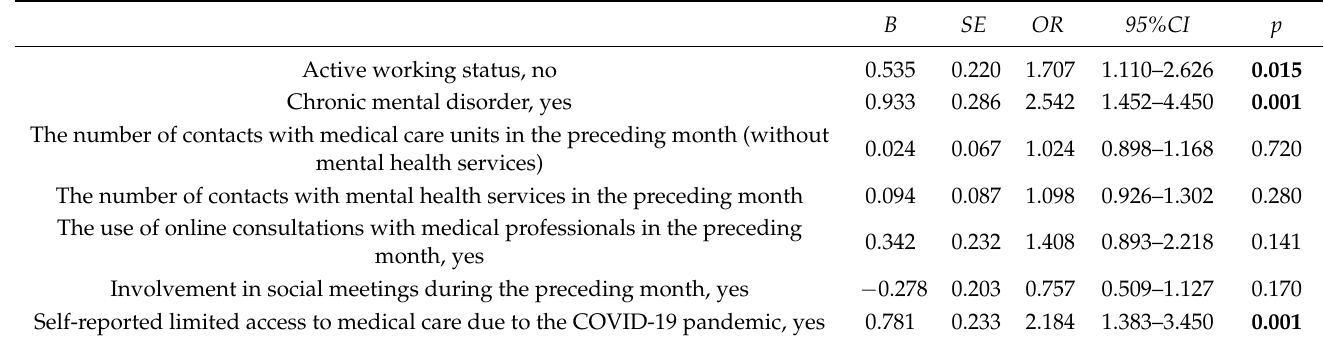
B SE OR 95%CI p